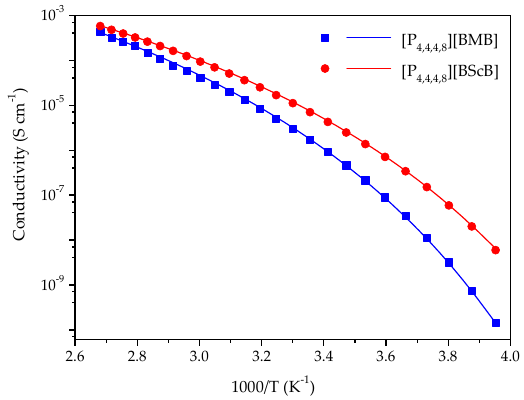
Figure 3. Temperature dependence of the ionic conductivities for [P 4,4,4,8 ][BMB] and [P 4,4,4,8 ][BScB] and the best fit of data using the VFT equation as indicated by the solid lines.